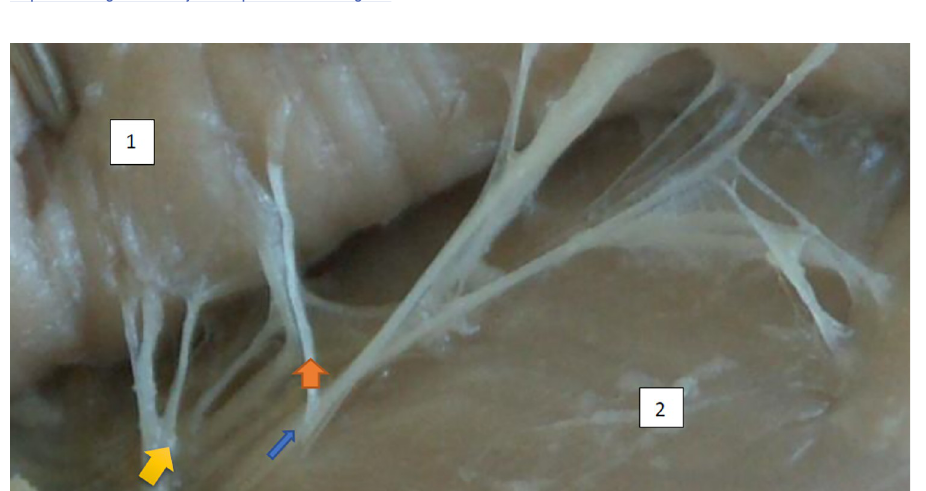
Fig 9. Superior gluteal nerve bushy type, vertical coursemorphological age 164–24–VI,v–tub191, v–pl 269. mass 489, male sex, magnification 20x, 1– gluteus medius muscle, 2– gluteus minimus muscle, red arrow–branch to gluteus medius muscle, yellow arrow–branch to gluteus minimus muscle, blue arrow–branch to tensor fasiae latae muscle.